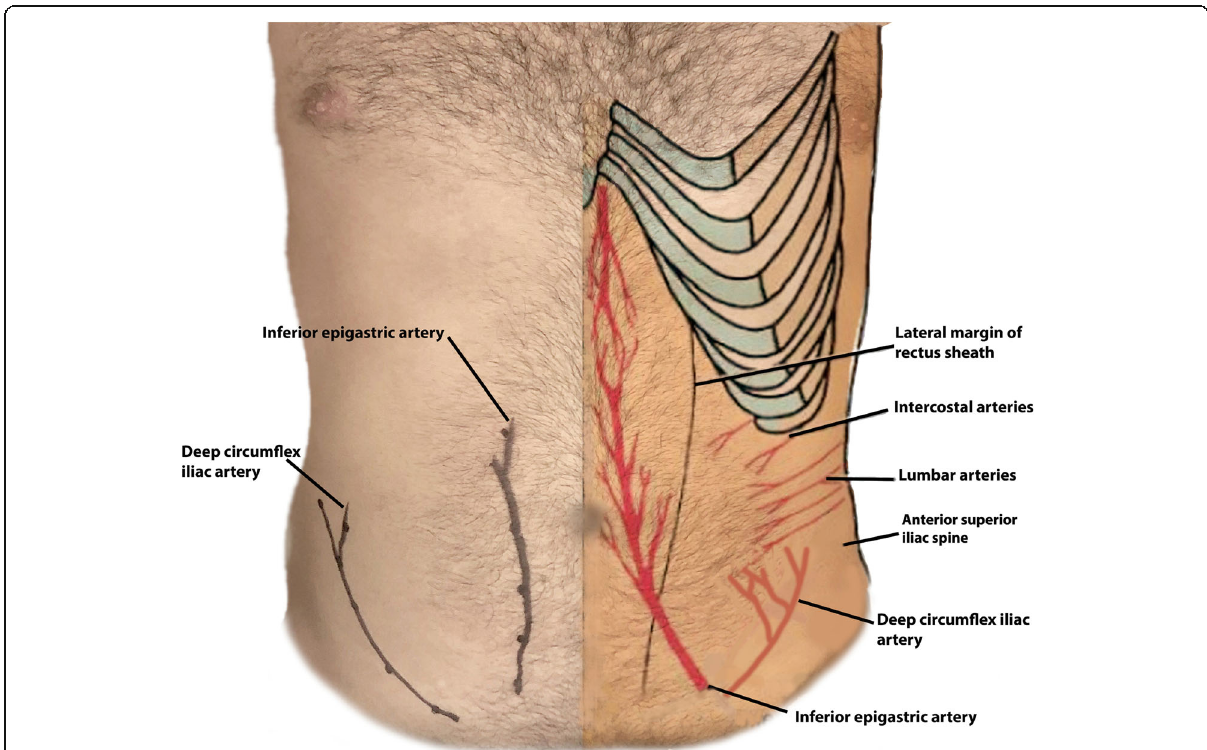
Fig. 3 Anatomic drawing of important anterior abdominal wall arteries superimposed on a healthy volunteer with the right hemi-abdomen demonstrating the course of the arteries obtained by Dopper ultrasound images, see Fig.